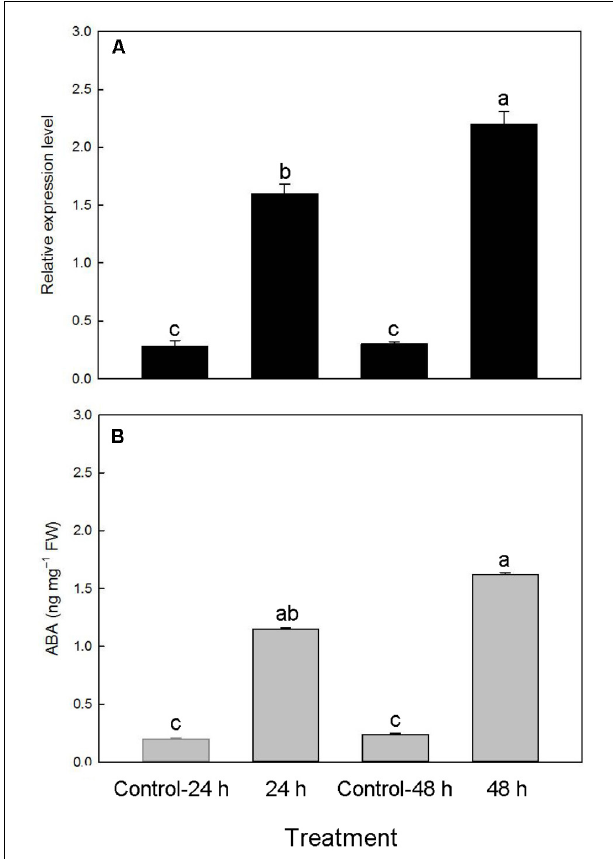
FIGURE 8 | Changes in accumulation of PtNCED1 transcripts (A) and ABA content (B) in response to dehydration in protocorms. 10% PEG 6000 was used for dehydration treatments for 24 and 48 h. Bars labeled with the same letter are not significantly different at P ≤ 0.05 by Fischer’s protected LSD